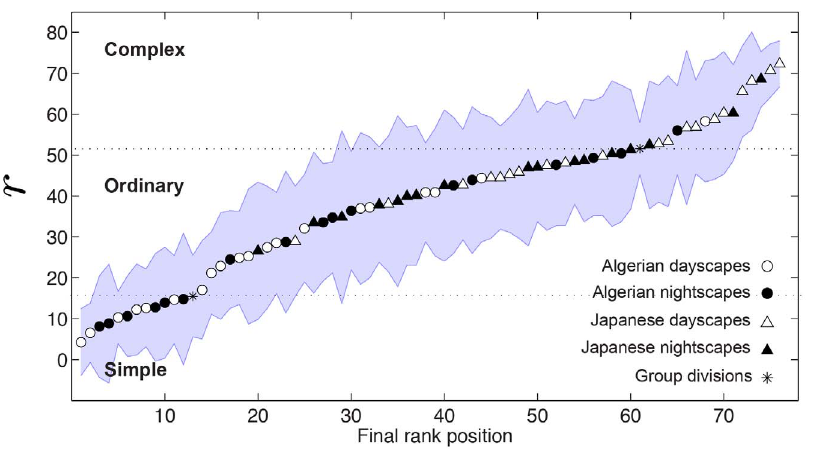
Figure 4. Subjective rank analysis. Streetscapes are organized in increasing order of r -values. Circles represent Algerian streetscapes. Triangles represent Japanese streetscapes. Unfilled circles/triangles denote dayscapes. Filled circles/triangles denote nightscapes. Stars ‘‘*’’ represent group divisions. The blue shade represent the standard deviation around r .